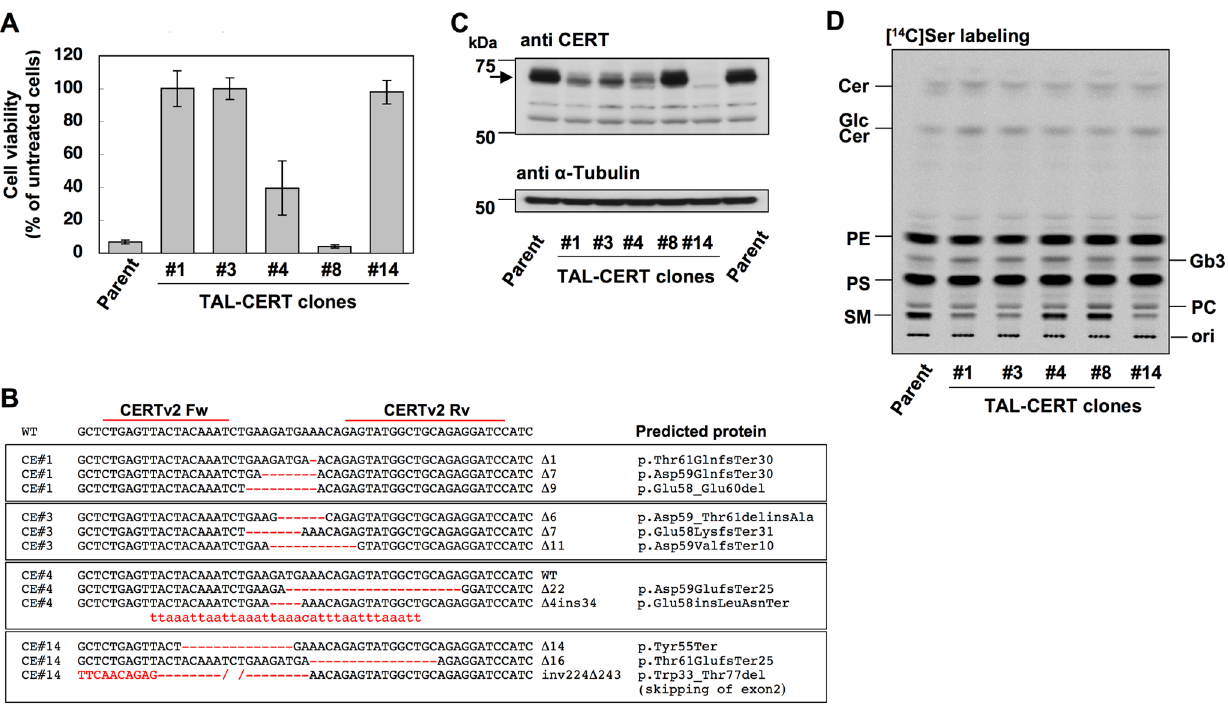
Figure 4. Isolation of CERT -deficient HeLa cell clones. A, Resistance to lysenin in HeLa TAL-CERT clones. The clones were treated with lysenin at 670 ng/ml for 2 h. Their viability was estimated by the MTT assay: mean percentage 6 S.D. obtained from three independently repeated experiments. B, Indel analysis of CERT gene in TAL-CERT clones. Indels are shown in red and their lengths are specified on the right of the sequences. The predicted proteins are indicated based on the recommended description (see Materials and Methods) [50]. C, Protein levels of CERT in TAL-CERT clones. Arrow indicates CERT protein at 68 kD. D, Metabolic labeling of lipids with radioactive serine. TAL-CERT clones were cultured with [ 14 C]serine for 16 h, and lipids extracted from the cells were separated by TLC. Radioactive image of an analyzed TLC plate is shown. PE, phosphatidylethanolamine; PS, phosphatidylserine; PC, phosphatidylcholine.